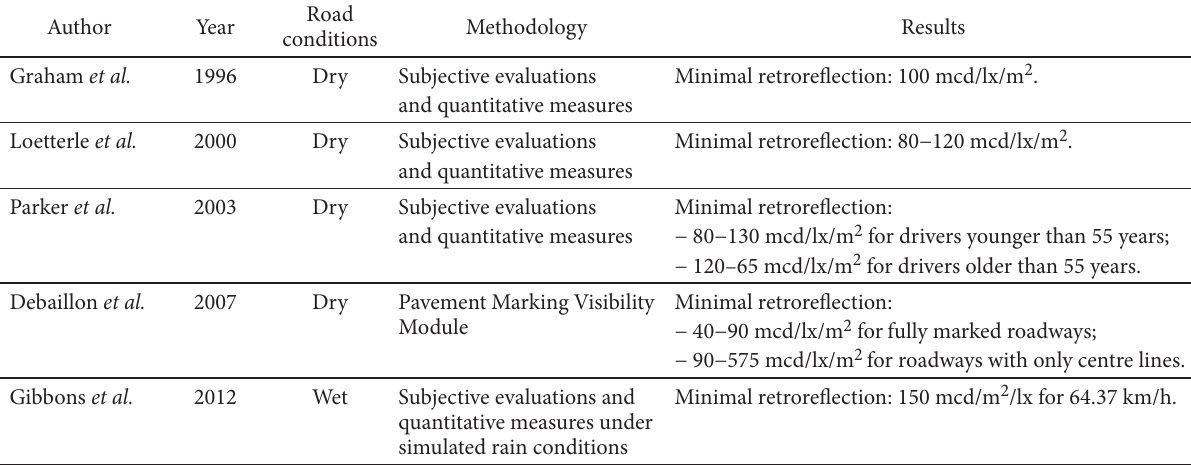
Table 1. Current research related to determining the minimum levels of